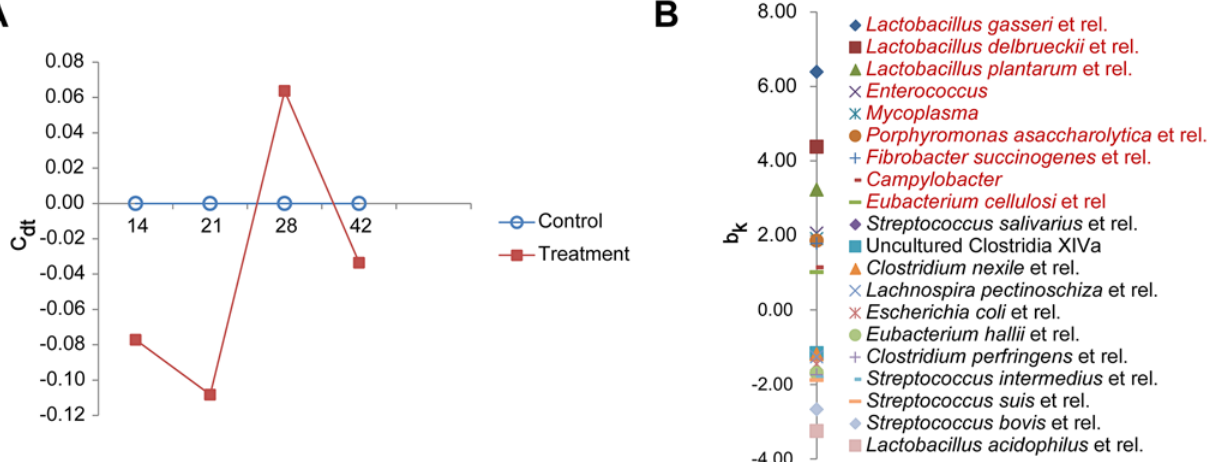
Fig 1. Effects of maternal antibiotic (ATB) treatment on colonic microbiota of offspring between 14 and 42 days of age (weaning at day 28). (n = 5 per treatment). A. Principle Response Curve (PRC) showed no overall significant effects of maternal ATB treatment on colonic microbiota composition in offspring, however, the microbial composition of the ATB group showed a remarkable shift between day 21 and 28 especially for those microbial groups depicted in the B-panel. C dt , canonical coefficient. B. The relative contribution of bacteria (red) with a positive species weight (bk) was lower in the ATB group compared to the treatment group on day 14 and 21, but increased between day 21 and 28, and decreased again after weaning at day 28; while those (black) with a negative species weight (bk) showed an opposite